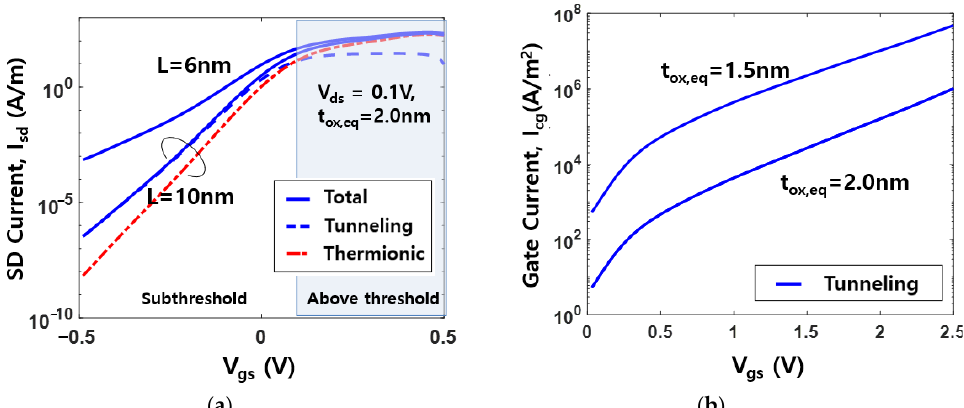
Figure 2. ( a ) Calculated SD current versus V gs for V ds = 0.1 V ( b ) calculated gate tunneling current versus V gs for different t ox , eq .